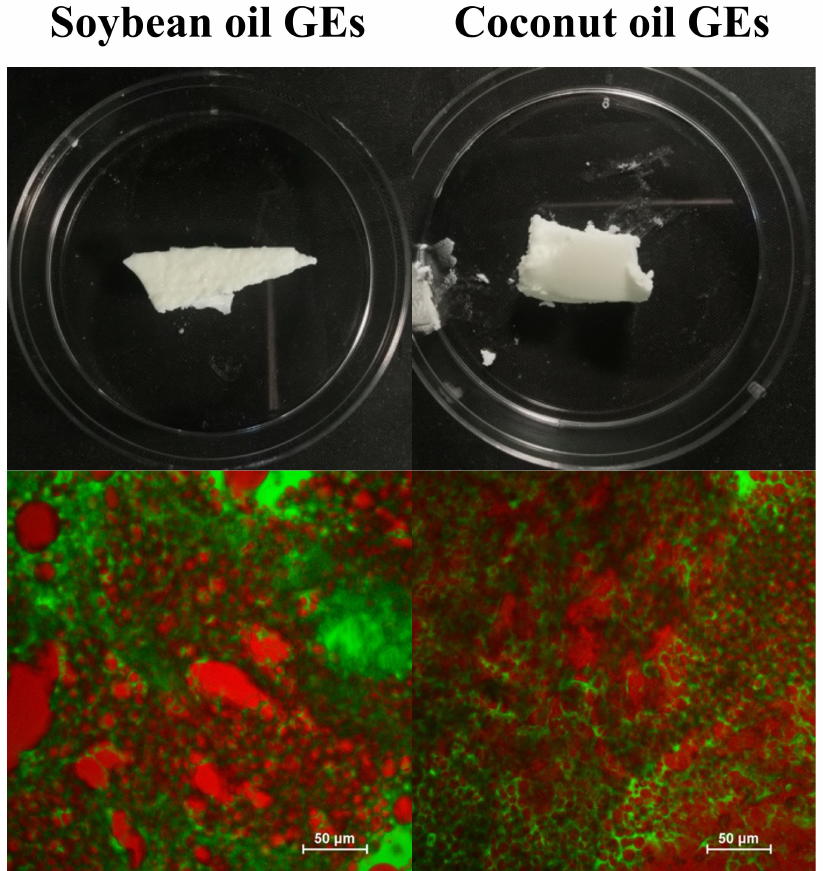
Figure 10. Appearance and microstructure of soybean oil gelled emulsions and coconut oil gelled emulsions. The fat phase is stained red and the proteins are stained